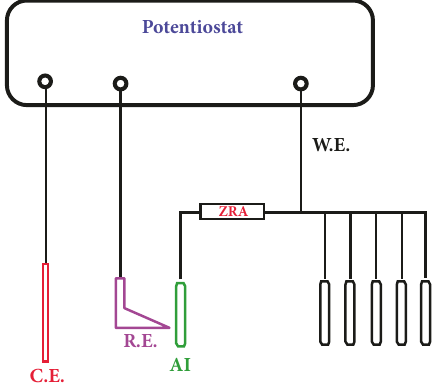
Figure 1: The circuit used for potentiodynamic polarization